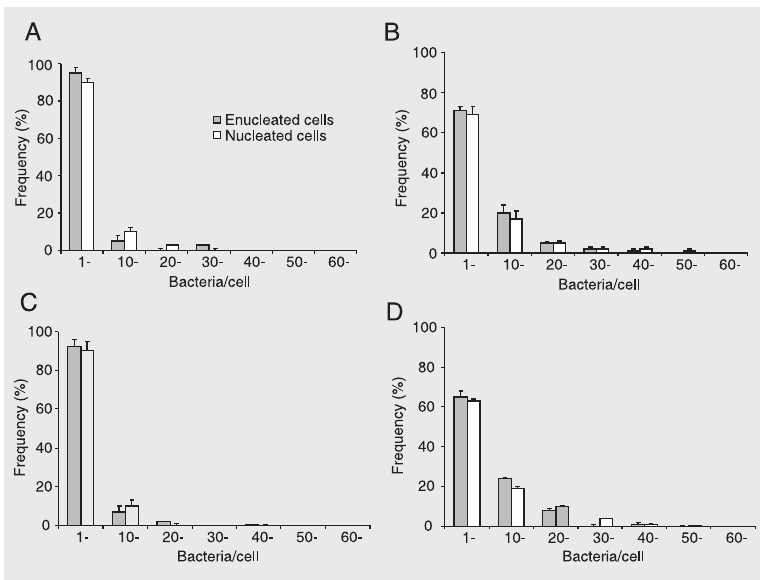
Figure 4. Effect of enucleation on percent infection of nucleated and enucleated cells as a func- tion of cytoplast age. Triplicate cultures were fixed at 2 and 3 h of infection. Data are reported as means ± SEM. Cultures in- fected 2 h (A) or 24 h (B) after enucleation. Differences be- tween nucleated and enucleated cells attributed to cell age and to duration of infection were not statistically significant. Differ- ences between nucleated and enucleated cells were significant at all time points (P < 0.05, two- way ANOVA).